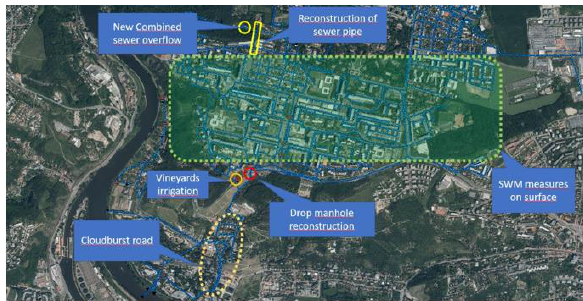
Figure 10. Setup of potential alleviation options for assessment